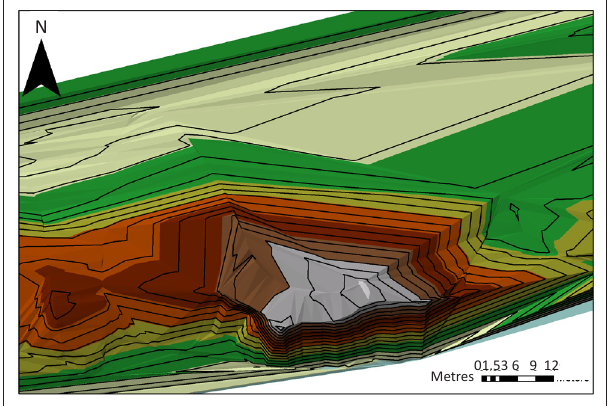
FIGURE 6: Contour on part of the beach at 0.2 m contour intervals.